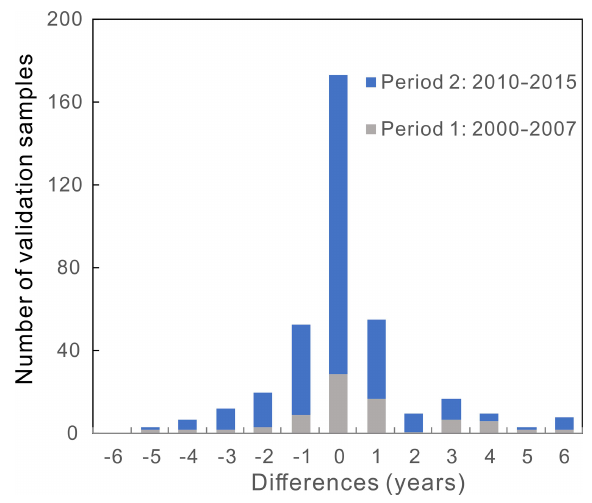
Figure 7. Difference between the detected change years using MODIS NDVI dataset and the exact change years from the refer- ence dataset (Google Earth and Landsat). Negative values on the x axis refer to the detected year being earlier than the actual change